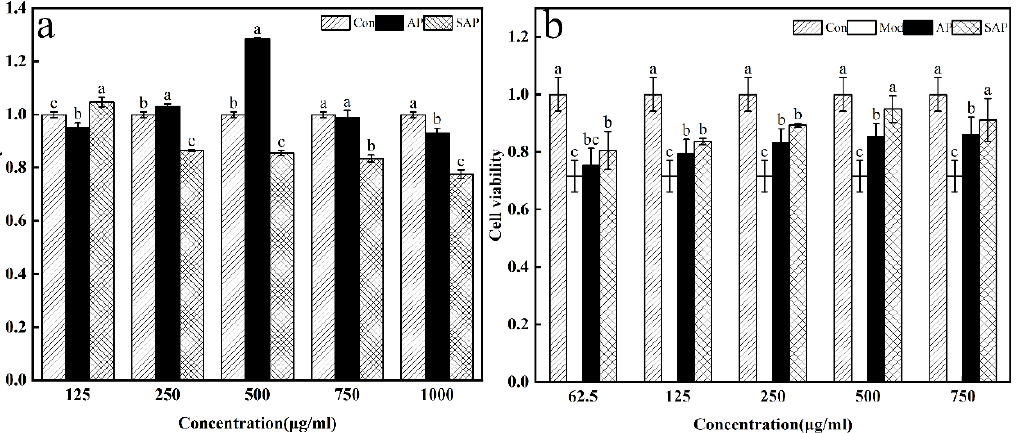
Figure 9. Cell viability. ( a ) Effect of different concentrations of AP and SAP on cell viability. ( b ) Effect of different concentrations of AP and SAP on cell viability of oxidatively stressed cells. Atthe same concentration, different letters in the graph indicate significant differences ( p < 0.05), and the same letters indicate no significant differences ( p > 0.05).